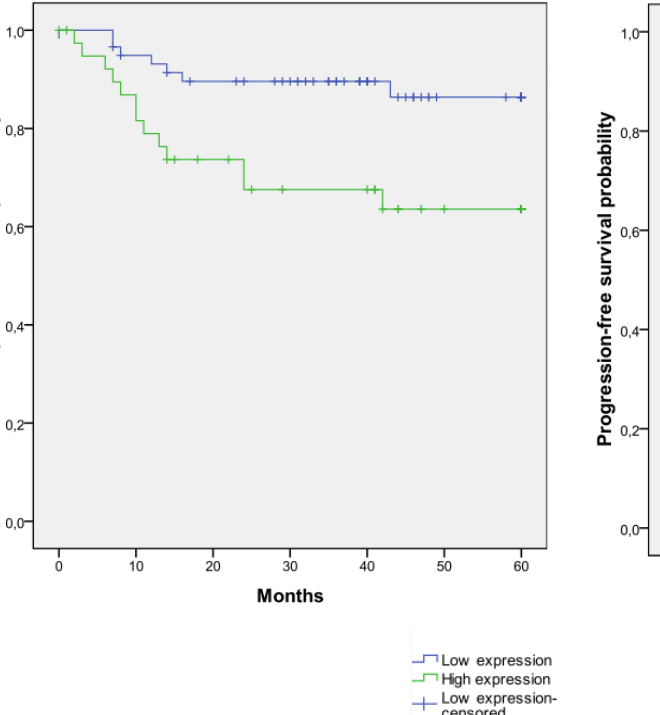
Figure 3 - Survival analysis based on cD44s expression. (a) Disease-specific survival (DSS) for low vs. high expression of cD44s. (b) Progression-free survival (PFS) for low vs. high expression of